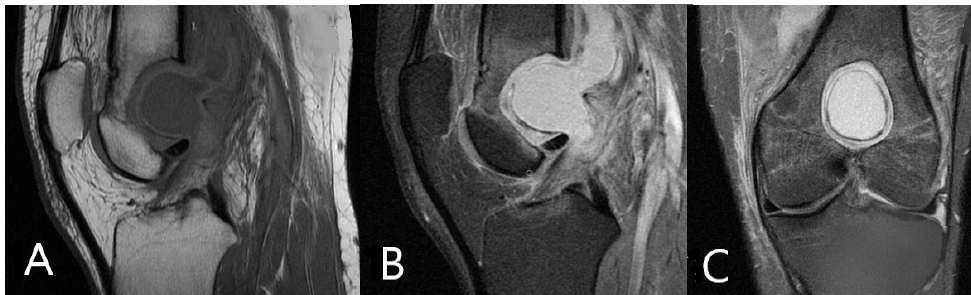
Figure 1. ( A ) T1 weighted MRI image demonstrating ‘penumbra sign’ described as perilesional lining of higher signal intensity, with a central hypo intense content. ( B ) Sagital plane image in fat suppression incidence showing extent of bone mass damage. ( C ) Frontal plane image also in fat suppression incidence demonstrating bone mass damage.